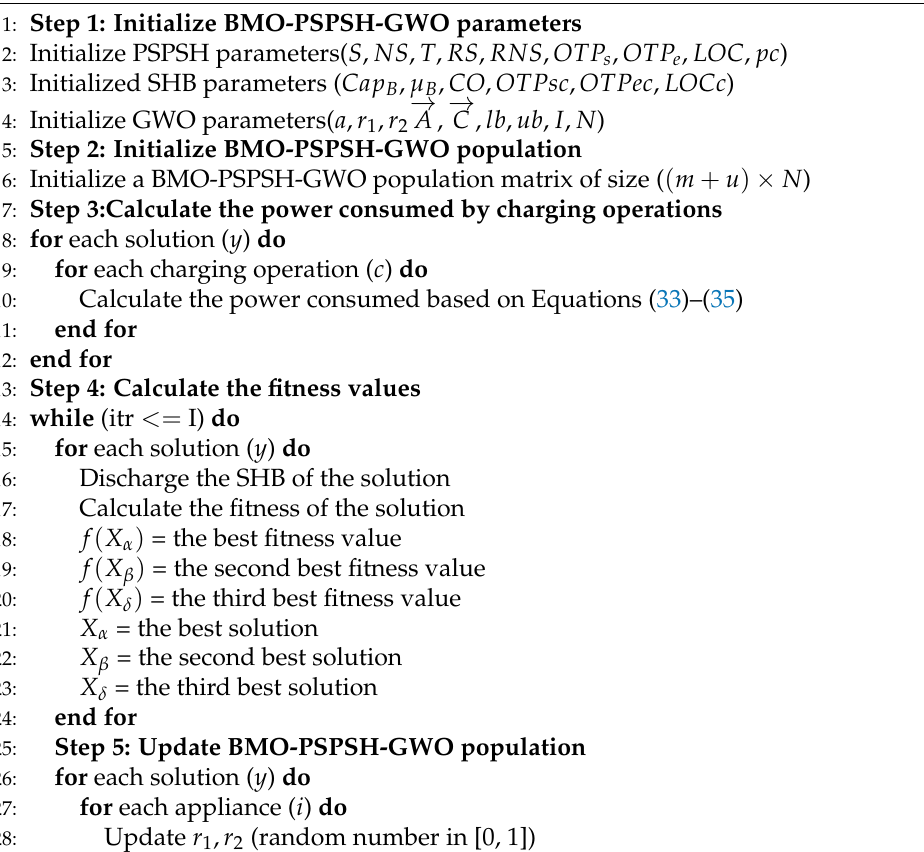
Algorithm 7 Pseudocode of the six steps of the proposed